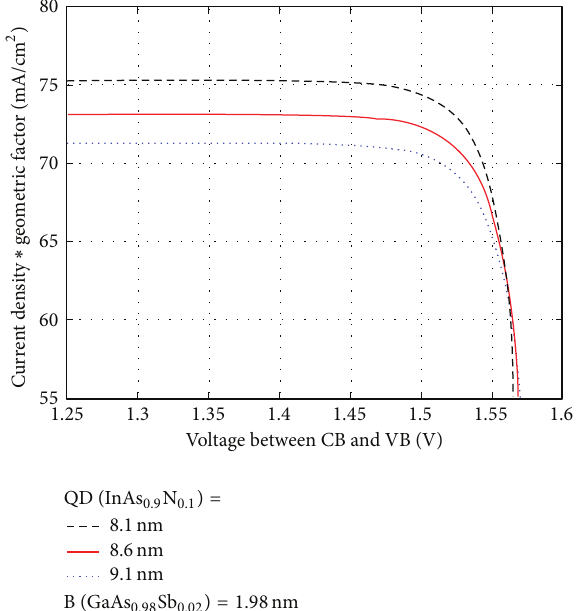
Figure 10: Current density for QDIBSC at full concentration with varying the quantum dot width and barrier width held constant.